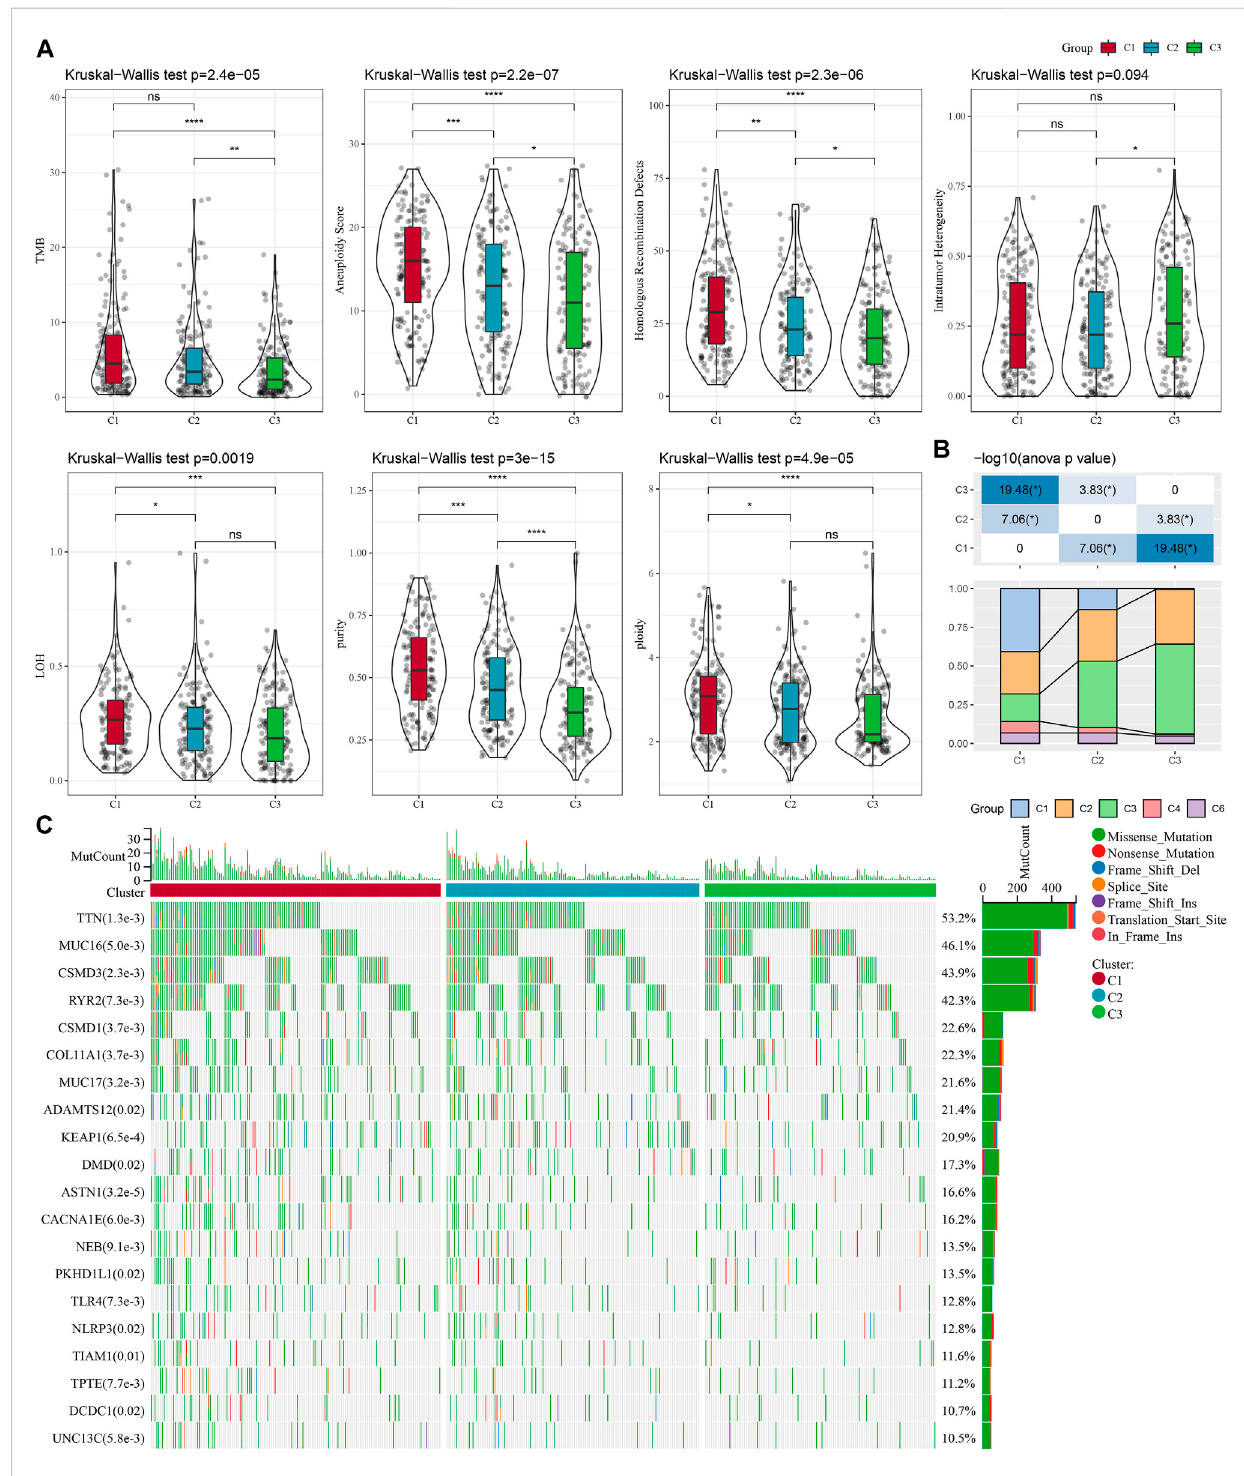
FIGURE 2 Genomic alterations in the molecular subtypes of the TCGA cohort. (A) Comparison of differences in Homologous Recombination Defects, Aneuploidy Score, Fraction Altered, Number of Segments, and Tumor mutation burden in the TCGA cohort molecular subtypes. (B) Comparison of the three molecular subtypes with immune molecular subtypes. (C) Somatic mutations in the three molecular subtypes (chi-square test). * p < 0.05; ** p < 0.01; *** p < 0.001; **** p <